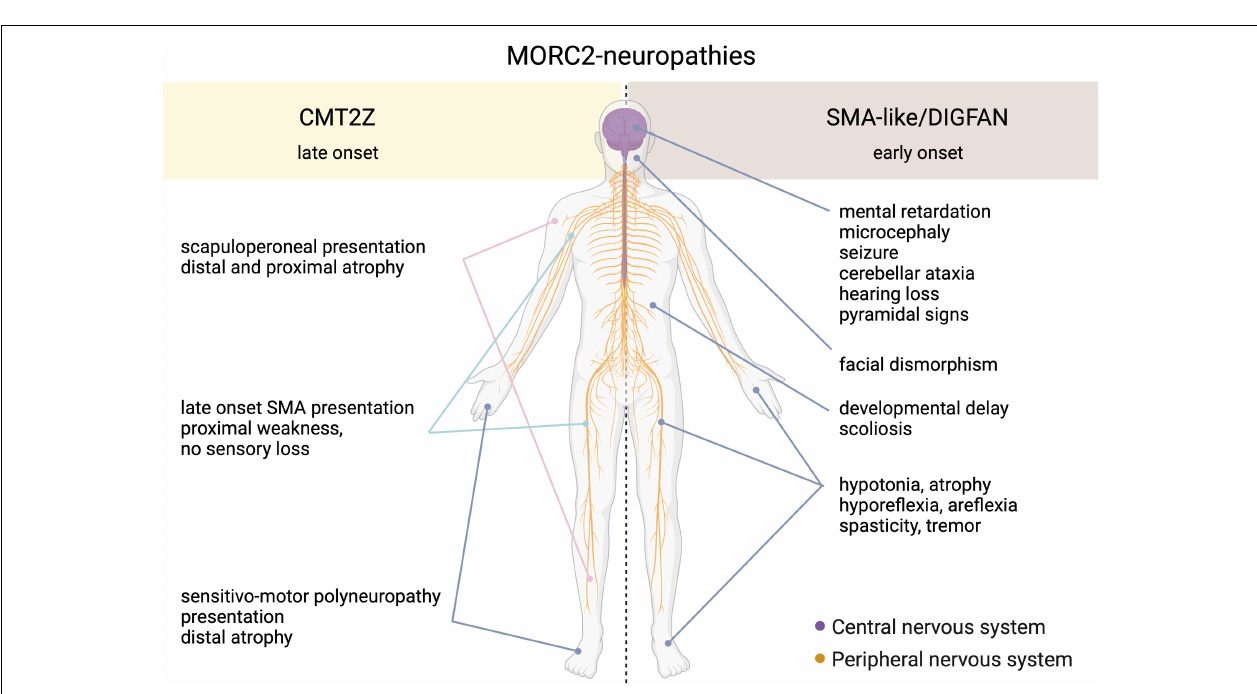
FIGURE 2 | Schematic representation of the clinical features in the spectrum of MORC2-related diseases. On one side, the late onset CMT2Z disease characterized by the peripheral axonopathy with a frequently scapuloperoneal presentation, or more rarely with a sensitive-motor polyneuropathy or a late-onset SMA presentation. On the other side, the early onset SMA-like/DIGFAN syndrome characterized by central and peripheral nervous systems damage, and developmental anomalies.